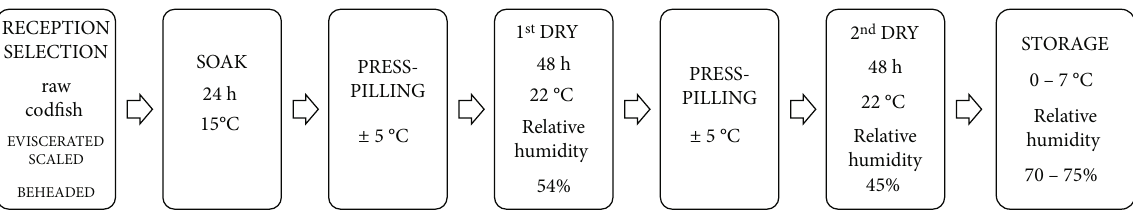
Figure 1: Diagram of the company ’ s preparation of yellow curing